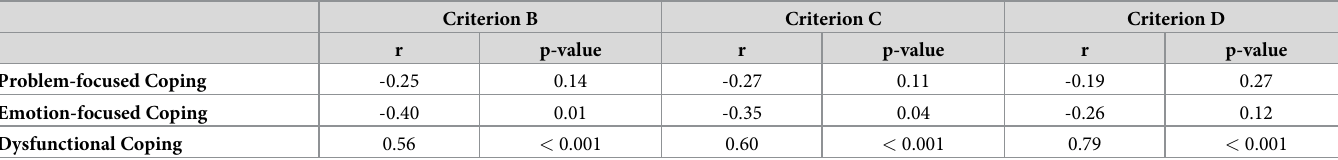
Table 2. Correlation analysis between coping style clusters and PCL-C symptom clusters.